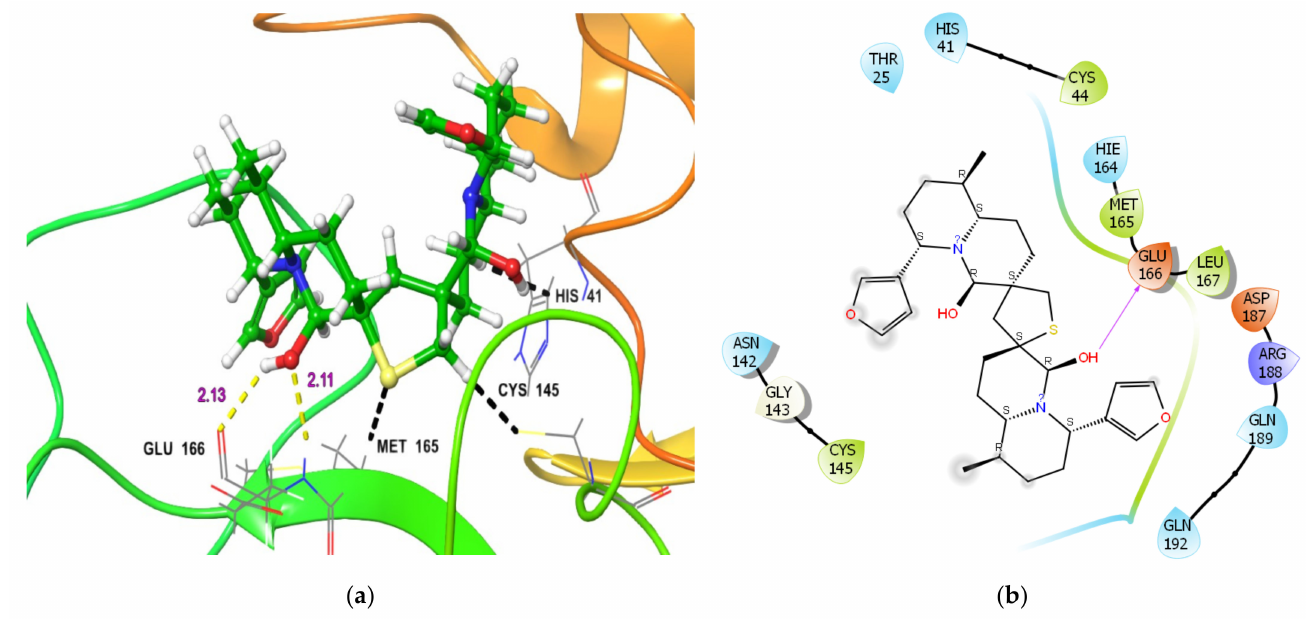
Figure 6. ( a ) 3-D representation of DTBN docked to M pro . H-bond interactions are displayed in yellow dotted lines, black dotted Line represent bad steric contacts/steric clashes, ( b ) 2-D Ligand interaction diagram of DTBN docked to M pro